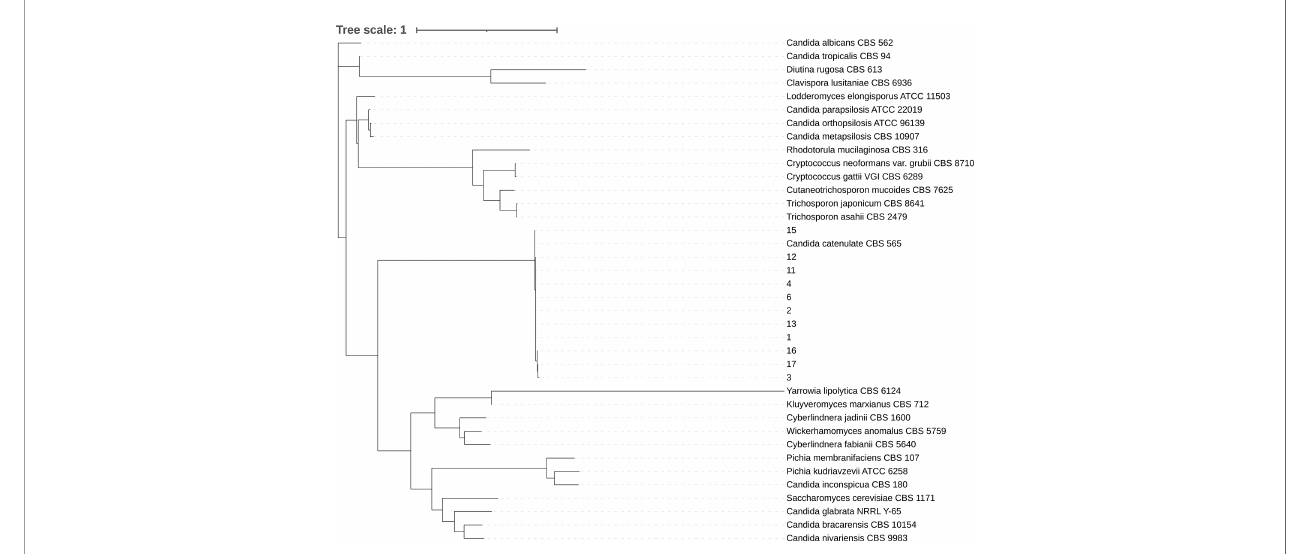
FIGURE 1 | Phylogenetic tree. Internal transcribed spacer (ITS) sequences of nuclear rDNA of Candida spp. were used. The ITS sequence of the model strain was obtained from NCBI gene bank. CLC sequence viewer software was used for sequence alignment and IQ-Tree ultrafast bootstrap with 1,000 replicates was used for tree